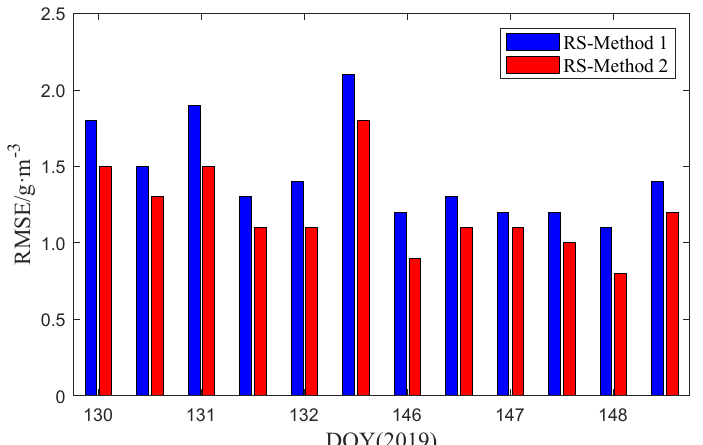
Figure 9. Root mean square error (RMSE) comparison between RS and the two tomography methods for the period of DOY 130–132, 146–148, 2019.